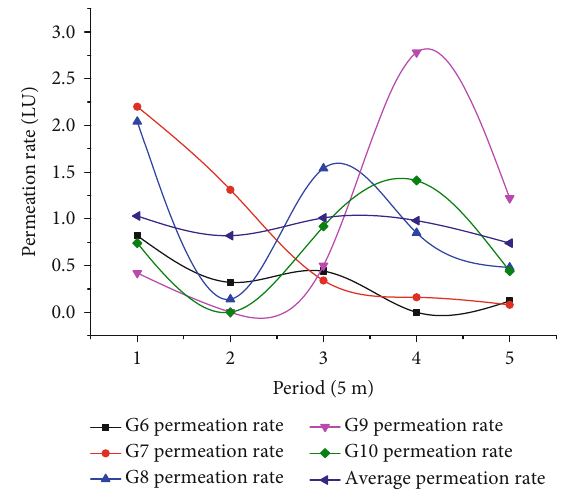
Figure 11: Permeability of test hole